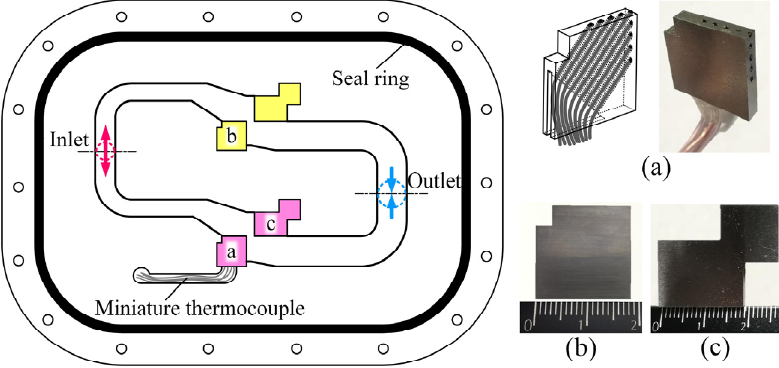
Figure 2. Parallel valve orifice experimental model: ( a ) Temperature measurement part; ( b ) Micro observation part; ( c ) Valve orifice assembly part.